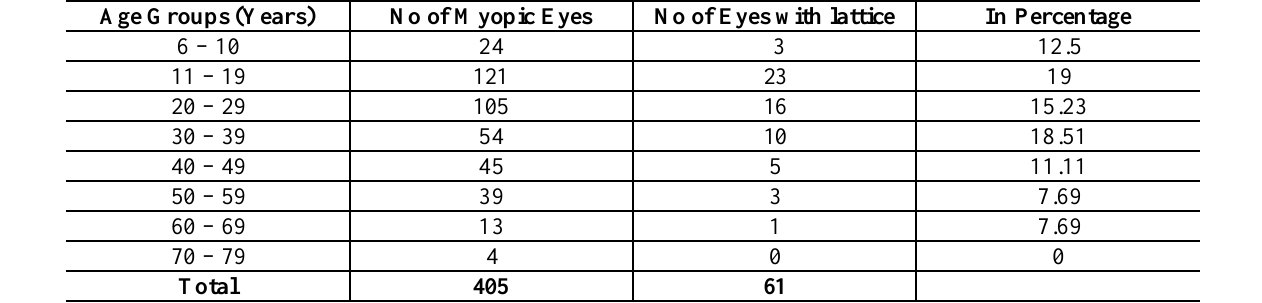
Table II : Distribution of Eyes According to Age